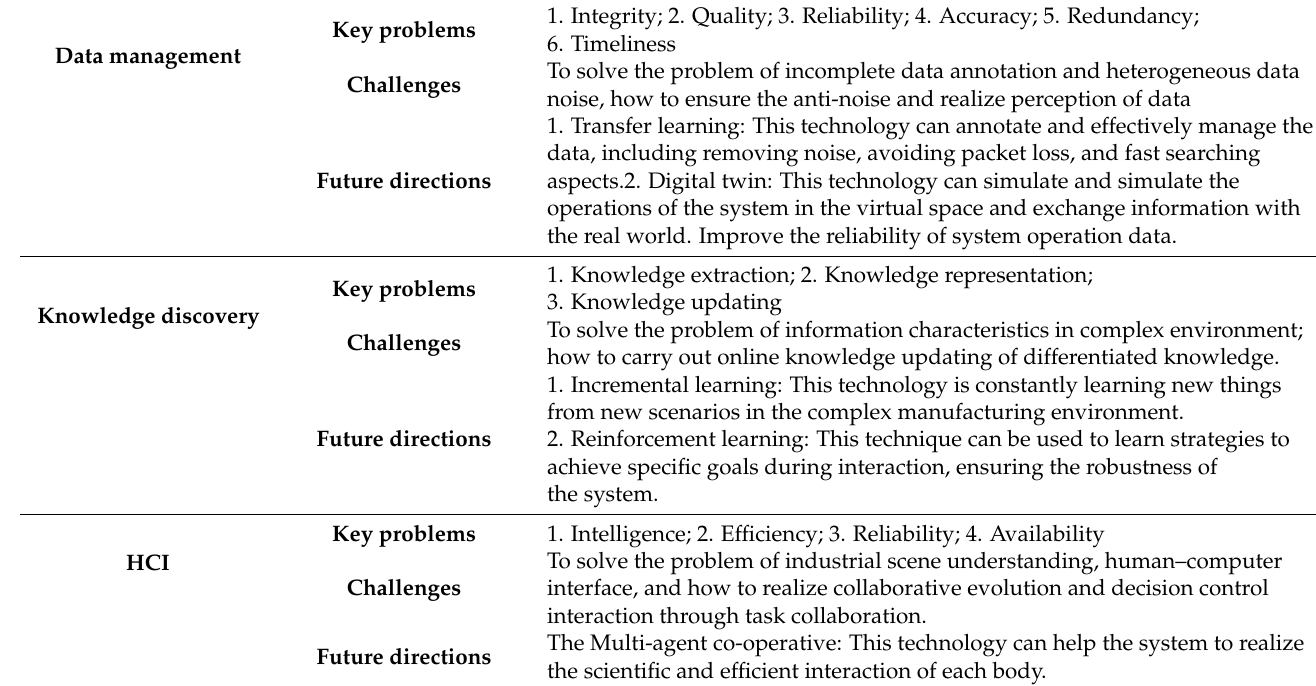
Table 2. A summary of current research challenges and future research